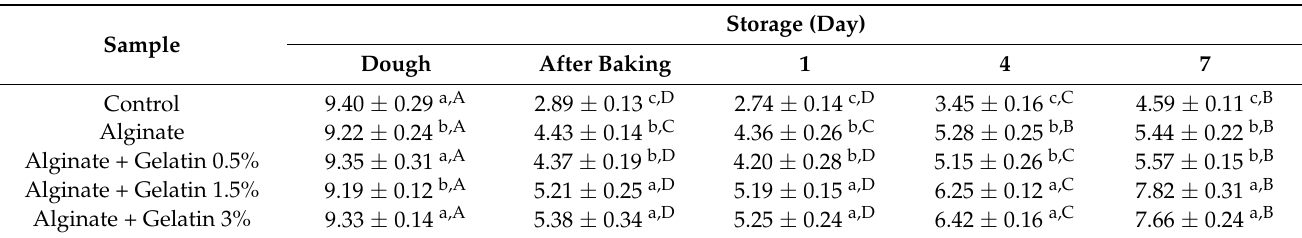
Table 2. The survival of L. acidophilus in bread before and after encapsulation in alginate/fish gelatin during the baking process and 7 days of storage (log